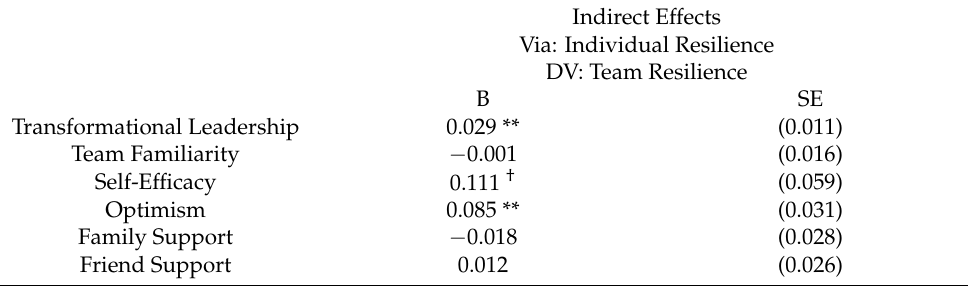
Table 6. Structural Equation Model (SEM): Indirect